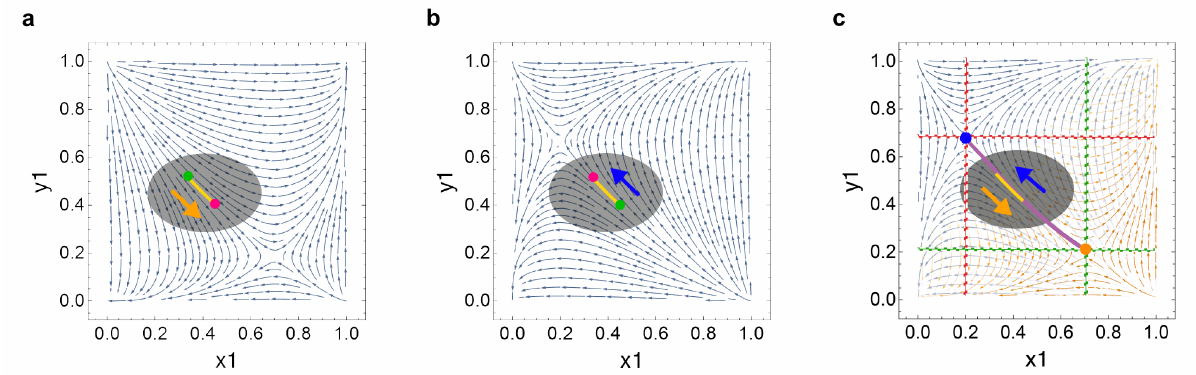
Figure 5. Concept visuals: Shepherding attractors and driven oscillation. ( a ) Evolution in bear market; ( b ) evolution in bull market; ( c ) driven oscillation. In ( a , b ), we plot the evolutionary trajectories for a bear and bull market. For each phase diagram, green denotes initial condition, red denotes ending destination and yellow denotes the evolutionary path. In ( c ), a reference attractor arc is plotted in purple and attractor positions at n = 0 and n = 1 are represented in orange and blue, respectively. The trapping zone orbit is plotted in yellow. The opaque black ellipse is a background element for visual contrast. This oscillation models ω = 0.5 and initial conditions n = 1 and ( 0.45,0.4 ) , the attractor position when n = 0.5. In this figure, we use a relatively large ω for the purpose of visualizing the evolution in ( a , b ). In ( c ), nullclines for n = 0 and n = 1 are illustrated in green and red, respectively. The central region demarcated by the nullclines is an attraction zone where trapping behavior is